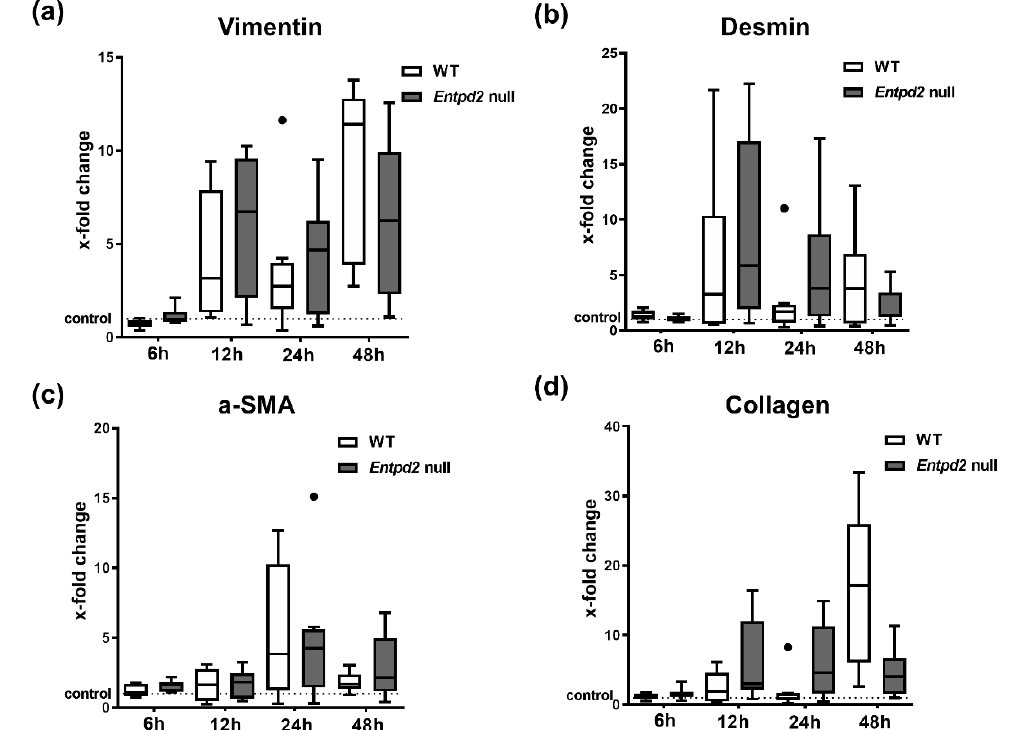
Figure 5. Hepatic expression of fibrosis-associated proteins after APAP intoxication. qRT-PCR analysis of total mRNA isolated from mice livers after APAP intoxication. Data are shown as fold-changes of mRNA expression relative to vehicle treated WT controls of ( a ) vimentin, ( b ) desmin, ( c ) smooth muscle actin (SMA), and ( d ) collagen.